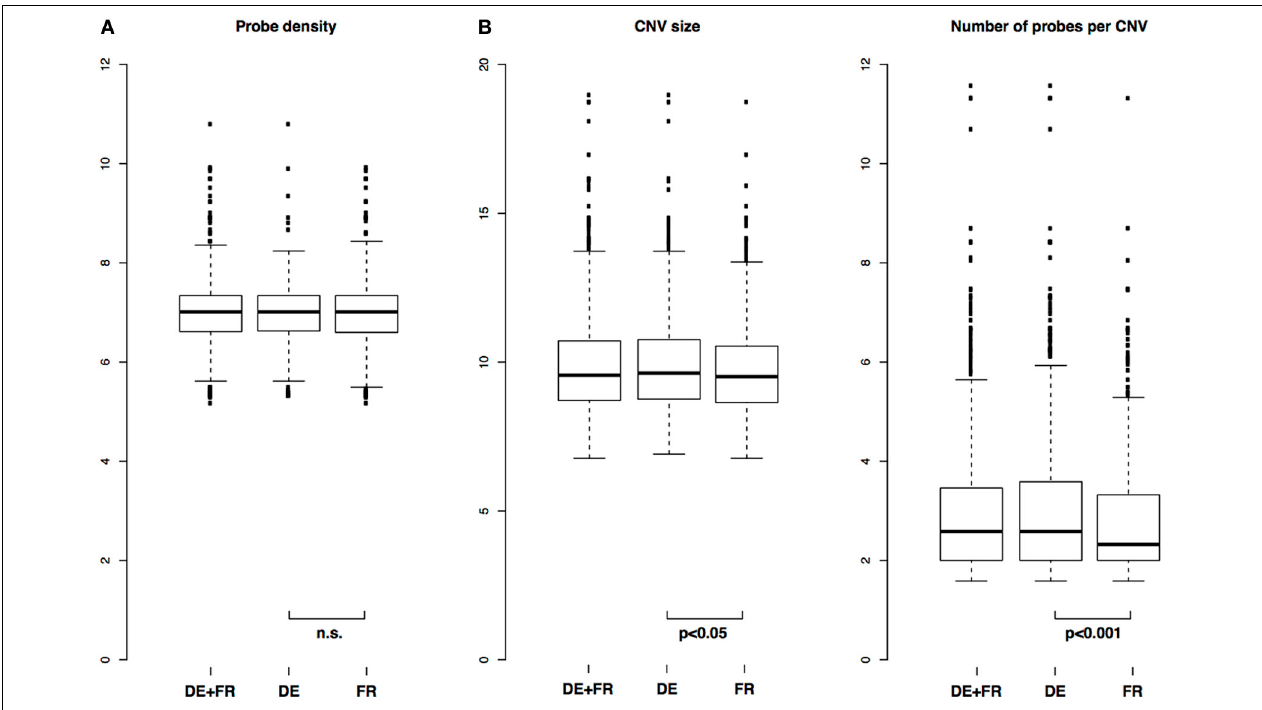
FIGURE 2 | Distribution of CNV length, number of probes and probe density in CNVs. (A) Comparison of distributions of probe densities in all samples and in each population separately and (B) Comparison of